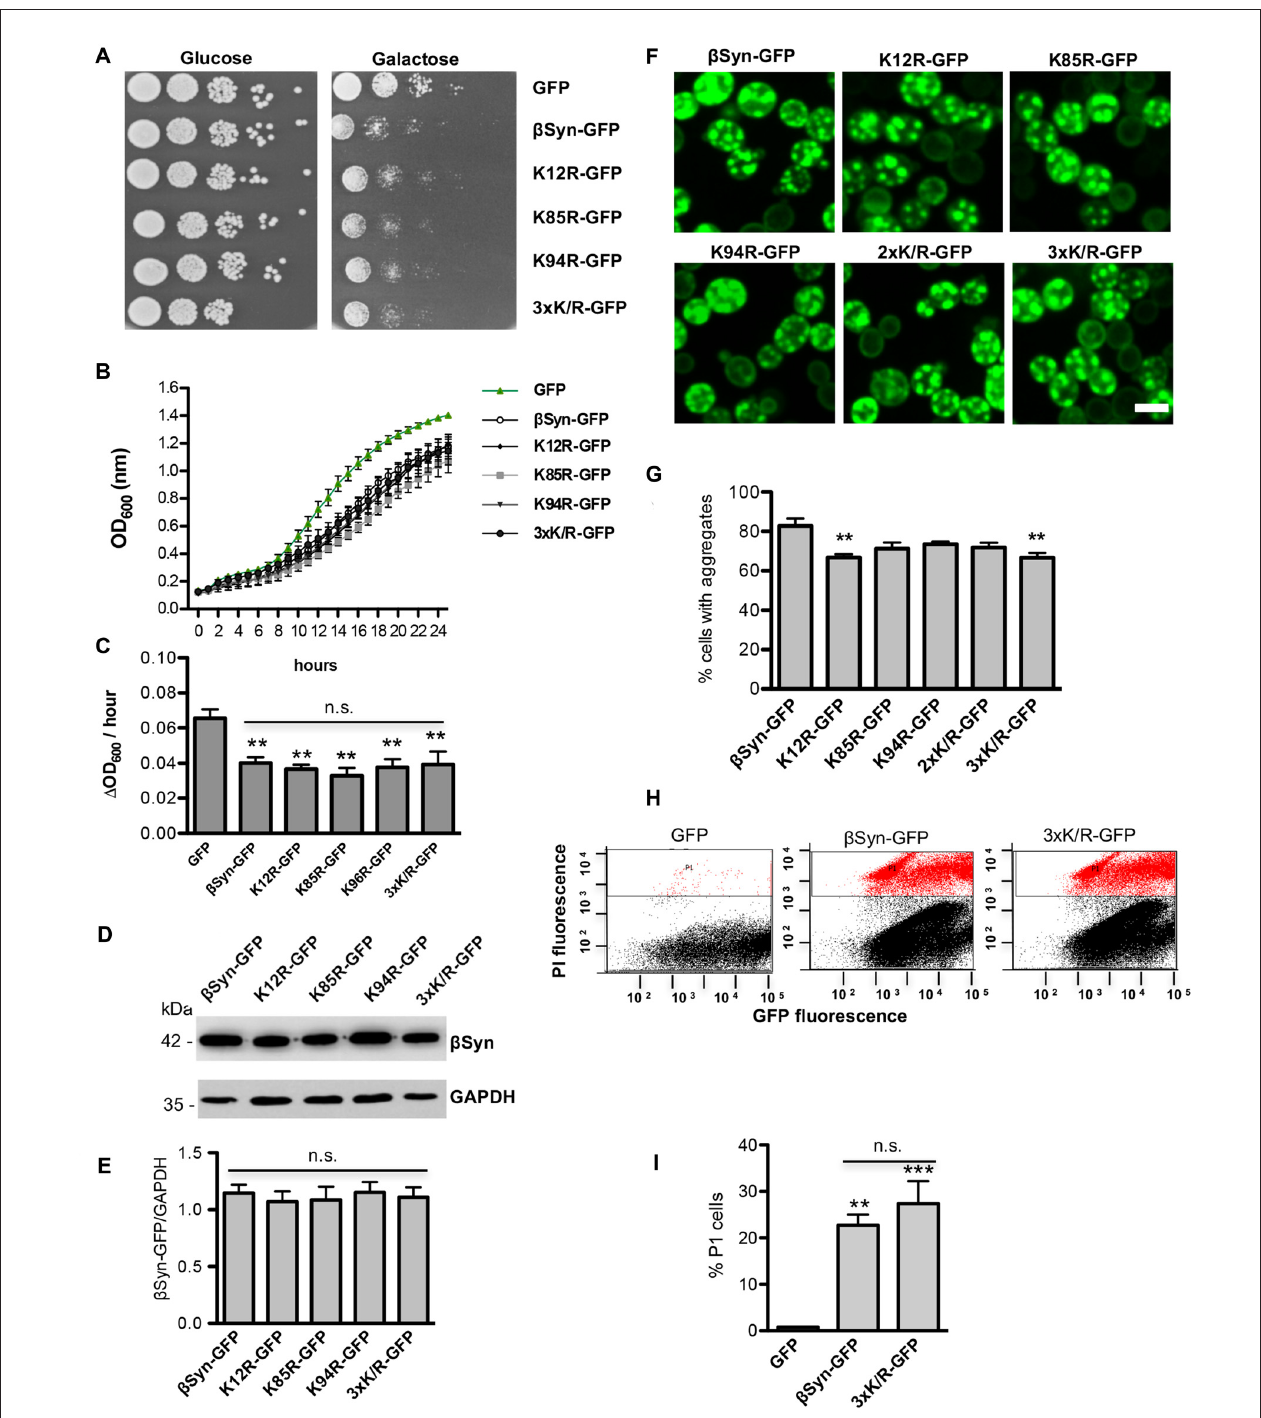
FIGURE 3 | High-copy expression of β Syn-GFP variants in yeast. (A) Spotting assay of yeast cells expressing GAL1 -driven GFP-tagged β Syn and β Syn SUMOylation deficient mutants K12R, K85R, K94R, K85R/K94R (2xK/R) or K12R/K85R/K94R (3xK/R) from 2 µ plasmids. GFP expressing plasmid was used as a control. Yeast cells were spotted in 10-fold dilutions on selective plates containing 2% glucose ( GAL1 “OFF”) or 2% galactose ( GAL1 “ON”). (B) Growth analysis of yeast cells from (A) in galactose-containing medium for 24 h. (C) Growth rate of yeast cells from (B) in logarithmic phase. Significance of differences to the GFP control was calculated with t -test ( ∗∗ p < 0.01; n = 4). One-way Anova test revealed no significant differences among the β Syn variants. (D) Western blot analysis of protein crude extracts from (A) after 6 h induction in galactose-containing medium. GAPDH served as a loading control. (E) Densitometric analysis of the immunodetection